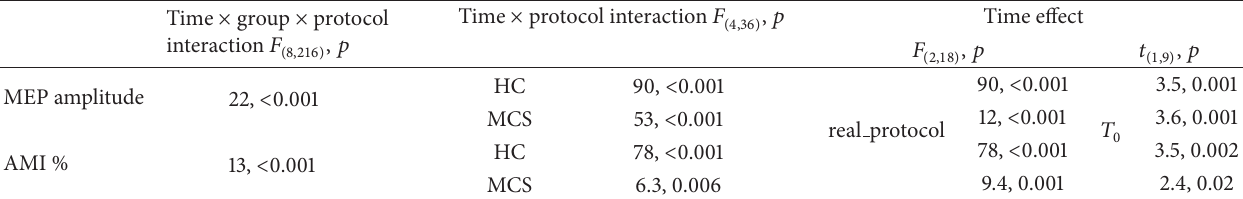
Table 3: We observed significant real protocol posteffects in the HC and MCS patients concerning MEP amplitude and AMI strength at 𝑇 , whereas the UWS patients did not show any significant posteffect. The rTMS alone and the rES alone did not induce any significant post posteffect. The nonsignificant interactions, factors, and time intervals are not